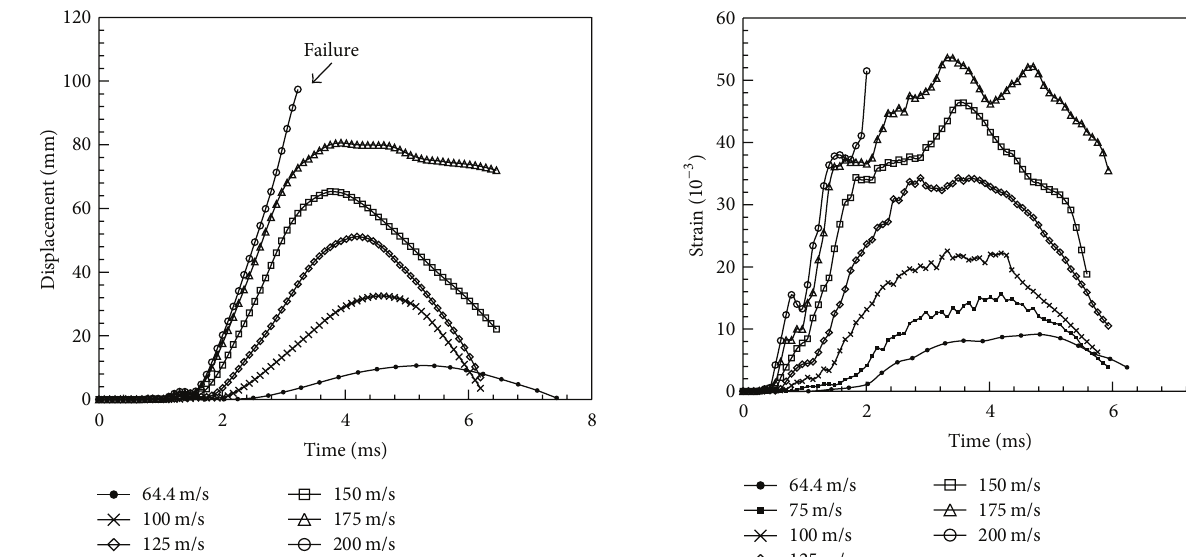
Figure 15: Effective strain history at Location